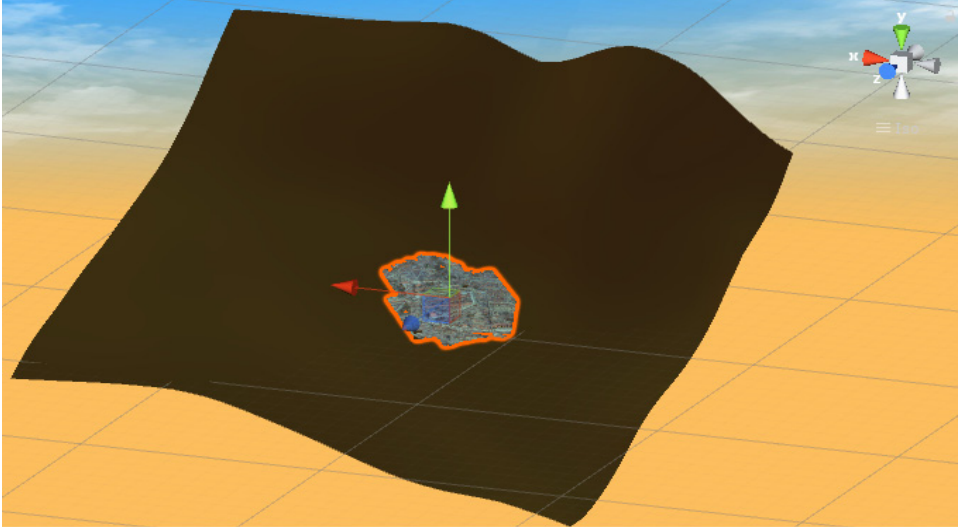
Figure 3. Terrain from Sketchup and balloon inside Unity 3D (© Authors).